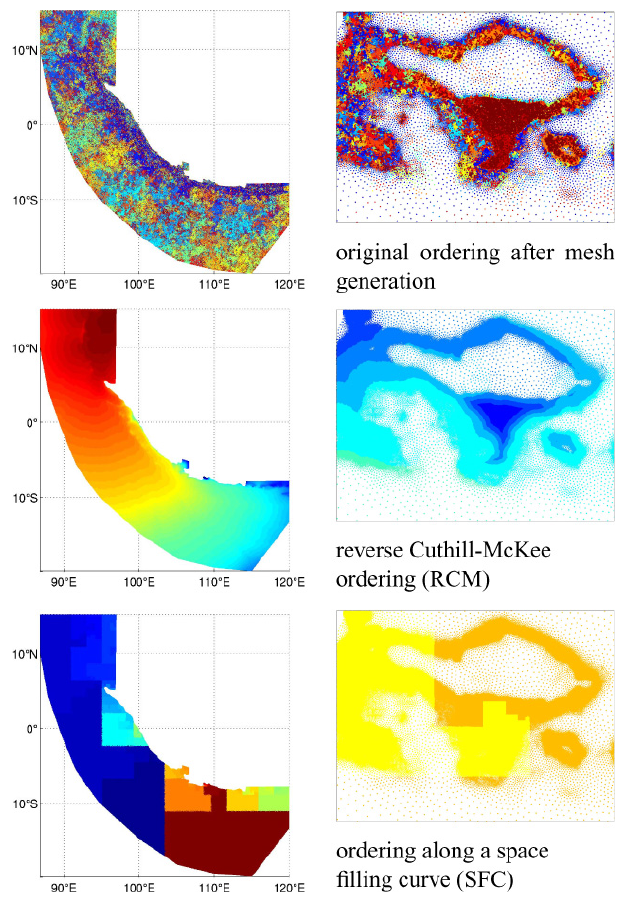
Fig. 1. Three different orderings of variables in the regional Indone- sian grid, from dark blue for the first node to dark red for the last one (2.3million). On the left for the whole domain, on the right a zoom at Bali region reduced to 16colours emulating the distribution on 16 OpenMP threads. Table 1. Computational time (s) for one TsunAWI time step, re- gional Indonesian scenario, on one blade of the SGI Altix UV